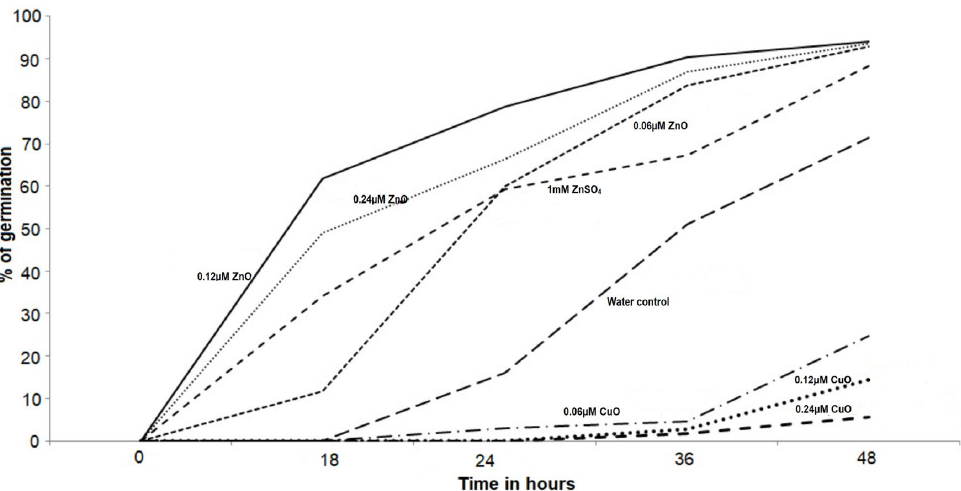
Figure 5. Seed priming of Amaranthus hybridus seeds with varying concentrations of CuO and ZnO nanoparticles to determine their optimal concentration for seed germination. A water control was maintained along with zinc salt control (1 mM ZnSO4).